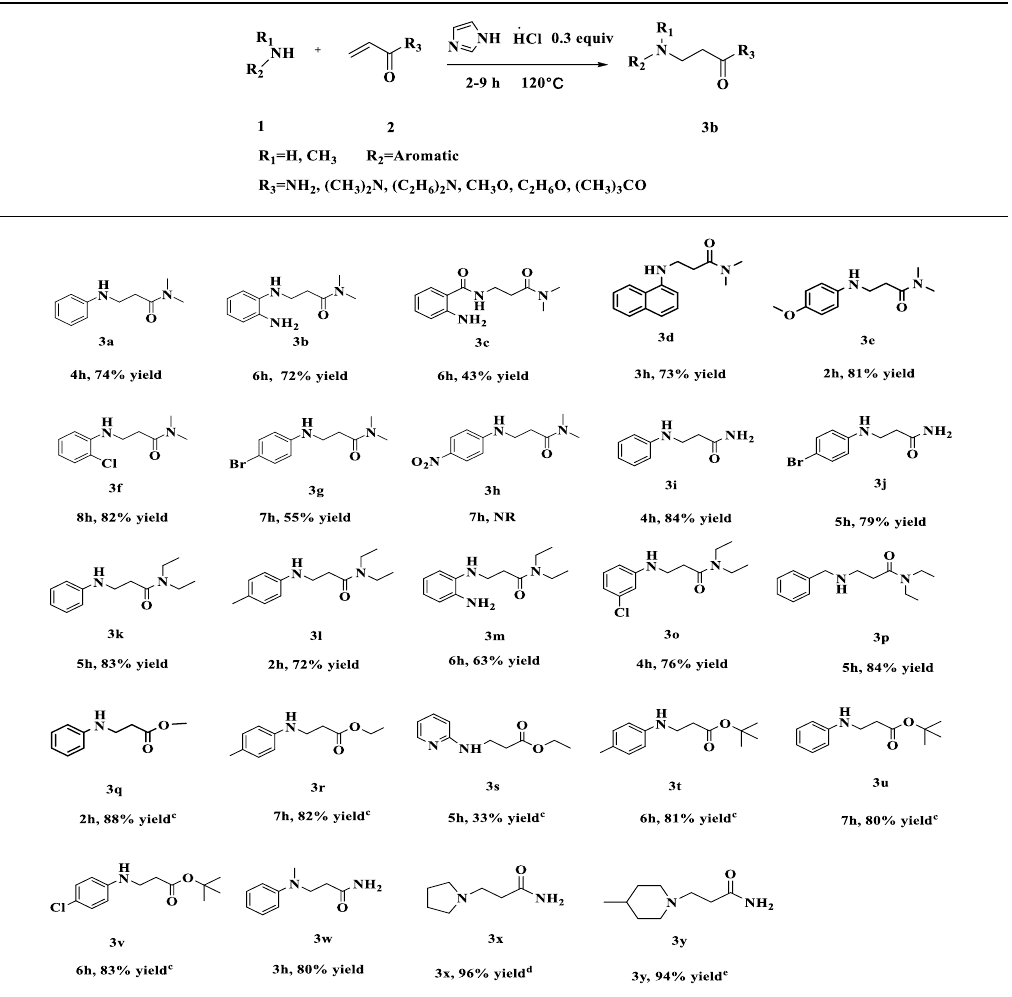
Table 4. Substrate scope of substituted amines and acrylamide derivatives a .